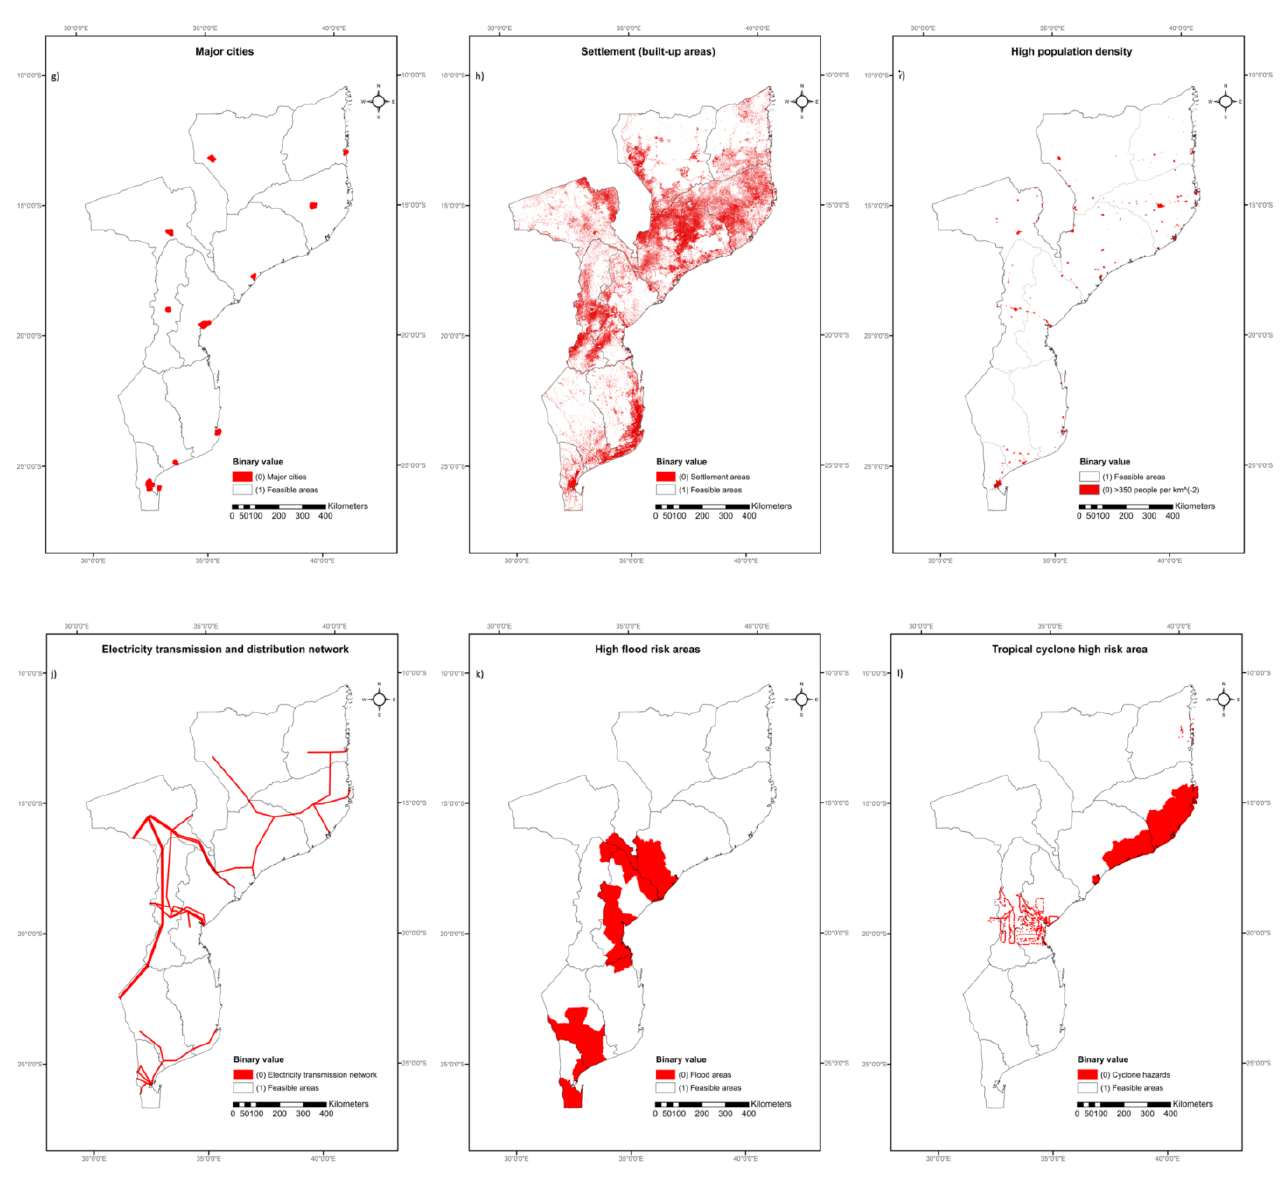
Figure A2. Maps with constraints considered for the analysis of the spatial suitability of off-grid solar PV microgrid projects in Mozambique. ( g ) Major cities, ( h ) settlement, ( i ) high population density areas, ( j ) electricity transmission and distribution network, ( k ) high flood risk areas, and ( l ) tropical cyclone high risk areas.